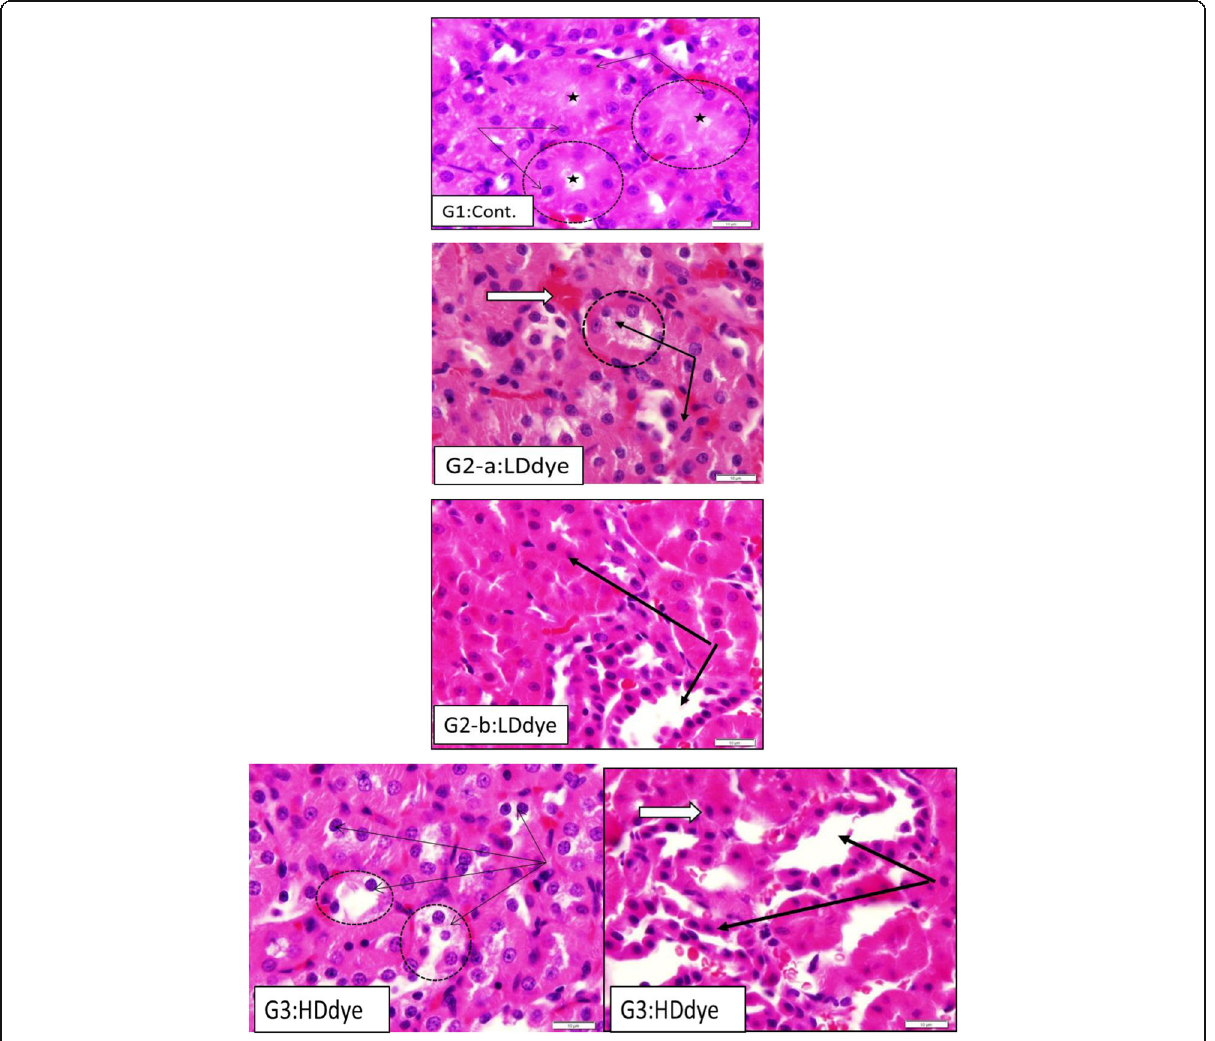
Fig. 4 Sections from the rat kidney show renal tubules of the following: G1: Co (control) group, proximal tubules (dotted circles) showing intact pyramidal cells surrounded by narrow lumen (stars), the cytoplasm highly acidophilic and rounded, vesicular (active) nuclei (arrows) are H-E, × 400. G2: LD dye (low dose) showing slight changes in proximal tubules in the form of increase cytoplasmic acidophilia and density of nuclei staining (signs of early apoptosis). Distal tubules showed dilated lumina with decrease height of lining epithelium. Some tubular cells showed unstained cytoplasm (H-E, × 400). G2-a: LD dye (low dose) showing slight changes in proximal tubules in the form of increase cytoplasmic acidophilia and density of nuclei staining (signs of early apoptosis). Distal tubules showed dilated lumina with decrease height of lining epithelium. G2-b: LD dye showed loss of tubular outlines. The lumina were obliterated. The cytoplasm of cells is deeply stained, and the nuclei become smaller and deeply stained (signs of apoptosis). (H-E, ×400). G3: HD dye (high dose) showing disorganization of tubular shape, dilation (arrows), and signs of cell degeneration (unstained cytoplasm (dotted circles) with decrease nuclear size (dark stained) (white arrows) (H-E,